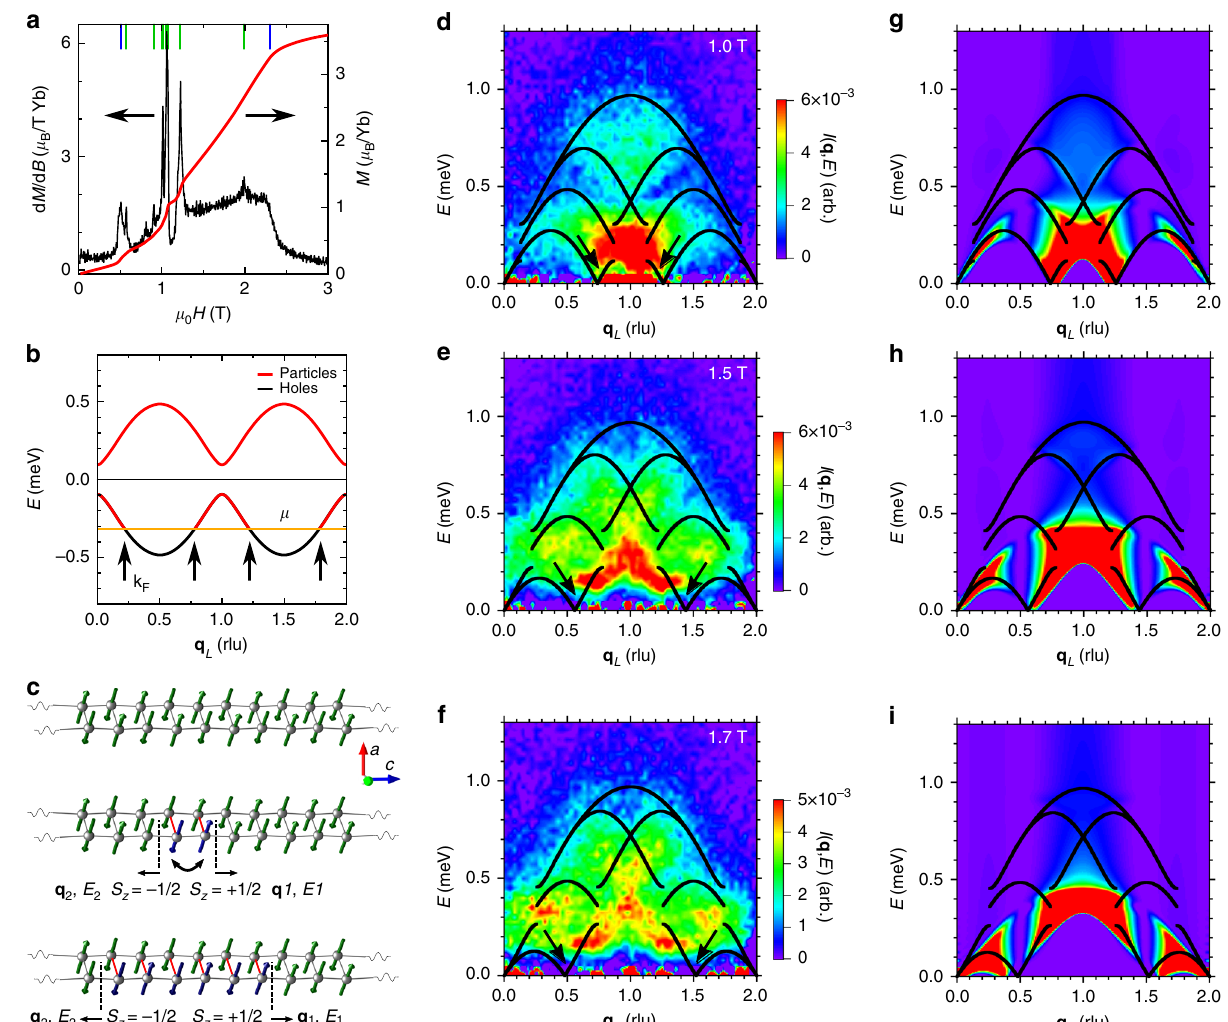
Fig. 2 Spinons in a magnetic fi eld. a The magnetic fi eld dependence of the static magnetization at k B T < Δ S [red, right axis, H ||(110)] shows several discontinuous jumps (blue and green dashes), corresponding to transitions among different 3D ordered phases that are more clear in d M /d μ 0 H (black, left axis) 23,25 . These phases correspond to different ways that magnetic moments arrange into registry minimizing the energy of magnetic dipole interactions between the Yb moments. b When a magnetic fi eld is applied along the chain direction, the chemical potential μ = − g μ B HS z (yellow) is lowered, emptying part of the hole band when | μ | > | Δ S |. μ crosses the hole dispersion at four points in the Brillouin zone (black arrows), de fi ning the Fermi wavevector k F . c Two AFM ordered, 1D spin chains (top). If two spins on one chain are interchanged, two domain walls are formed between the original domain (green) and a new one (blue). The new domain frustrates the interchain interaction, represented by the red interchain bonds. This frustration creates a linear potential con fi ning low energy spinons to bound states (bottom). d – f The magnetic excitation spectrum and its dispersion along the q L direction in reciprocal space measured at T = 0.1 K and μ 0 H = 1.0 T ( d ), 1.5 T ( e ), and 1.7 T ( f ), summed over − 1 ≤ q HH ≤ 1 rlu. The dispersions for the extremal combinations of particles and holes are shown (black lines) (See Supplementary Note 2). The spinon bound states are manifest from the enhanced low energy spectral weight around 1 ± 2 k F (black arrows). g – i The spinon spectrum computed using tDMRG calculations for the XXZ model Eq. (1) on a 96-site chain with Δ = 2.6 at equivalent chain magnetizations as ( d – f ), shown on the same color scale. The dispersions for the extremal combinations of particles and holes are also shown as black